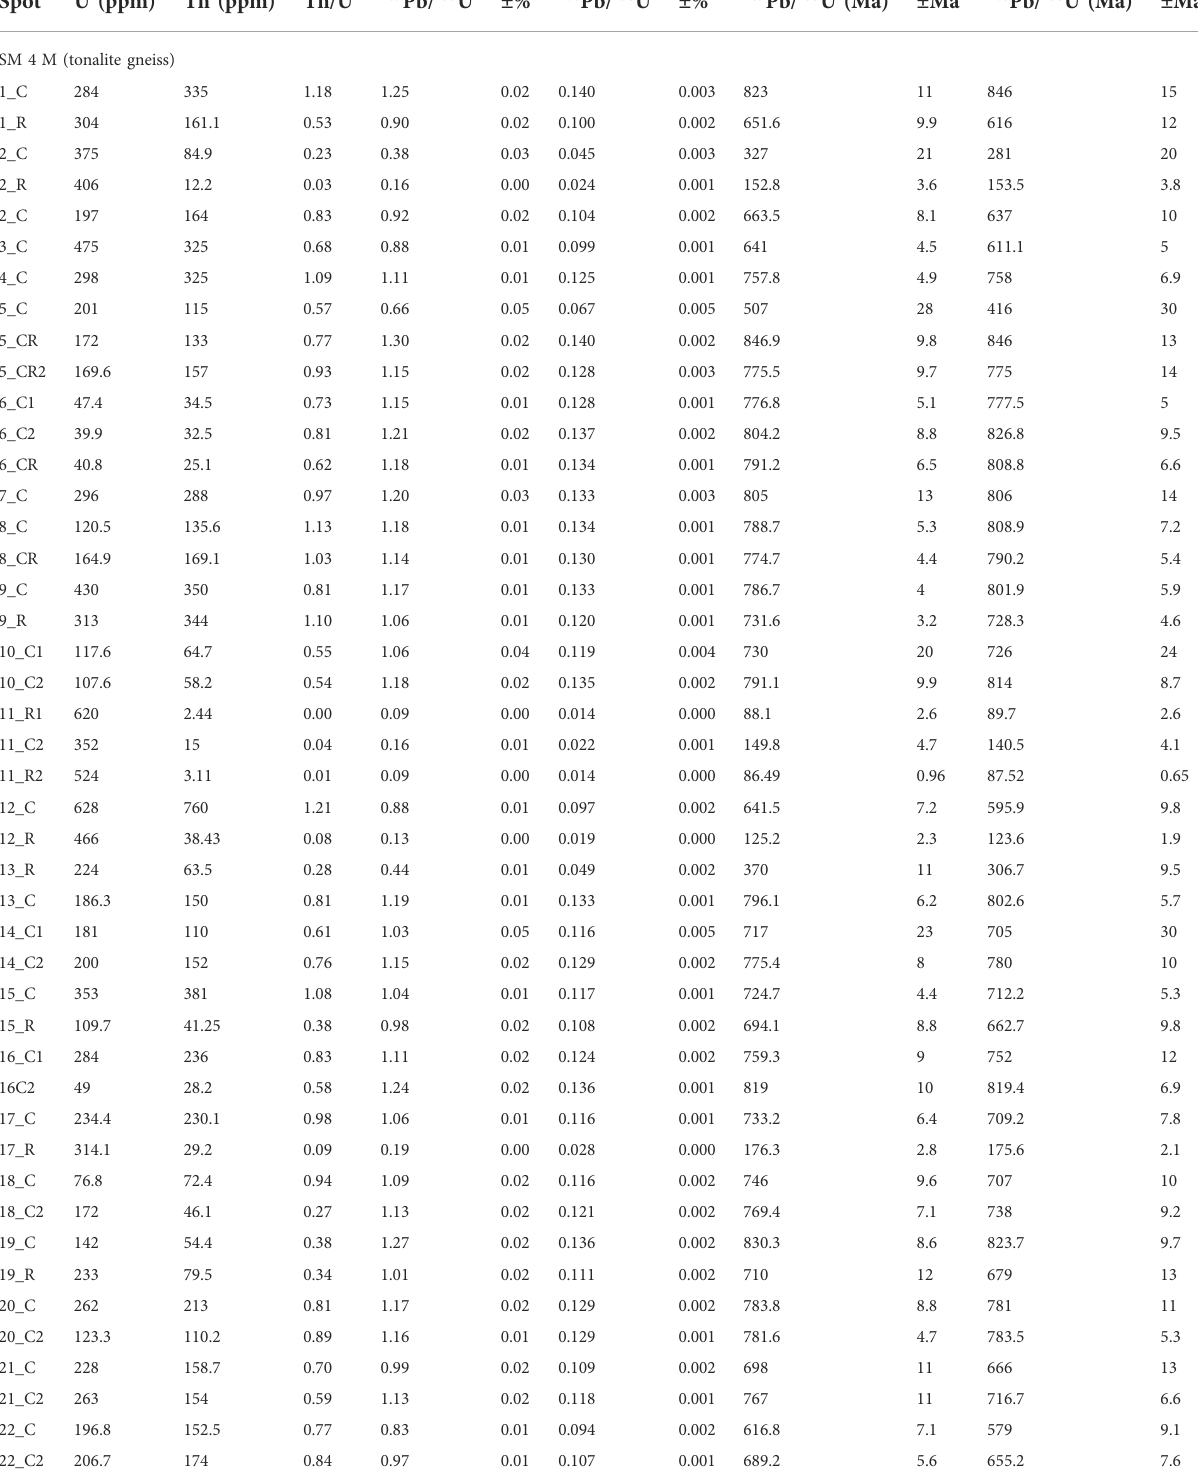
TABLE 1 U-Pb LA-MC-ICPMS isotopic data of analyzed tonalite gneiss from Karakoram Terrane, NW India.